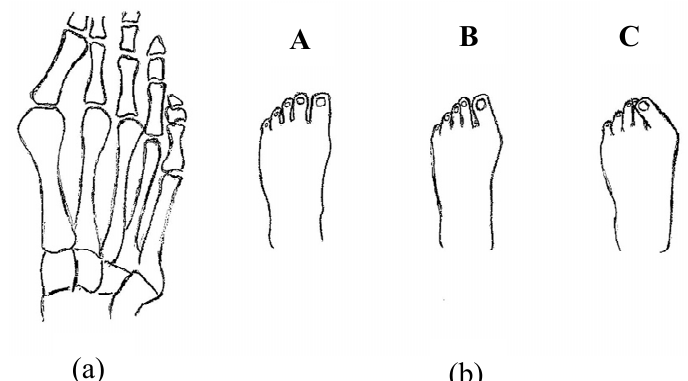
Figure 29. Toe deformities ( a ) bone positions and ( b ) the different level of deformities which deteriorate from normal toe position (A) to (B) to the worst posture (C) [56].